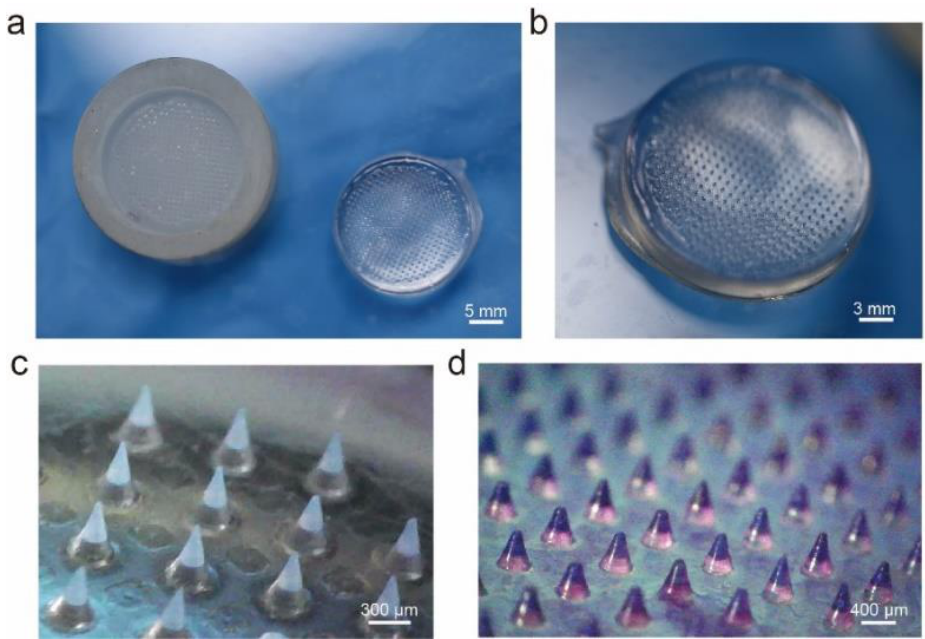
Figure 2. The pictures of ( a ) the microneedle mold and microneedle array patch, ( b ) a homogeneous microneedle array on the microneedle patch, ( c ) the microneedles with 0.01% purple food dye, and ( d ) the microneedles with 0.1% purple food dye under a stereomicroscope.